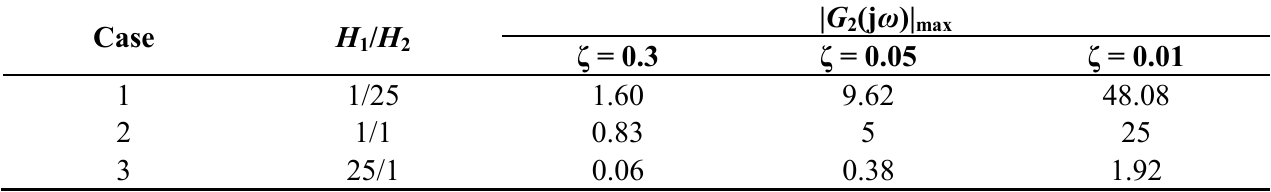
(j ω ) | with different inertia constant ratios and damping Table 1. |G 2 max